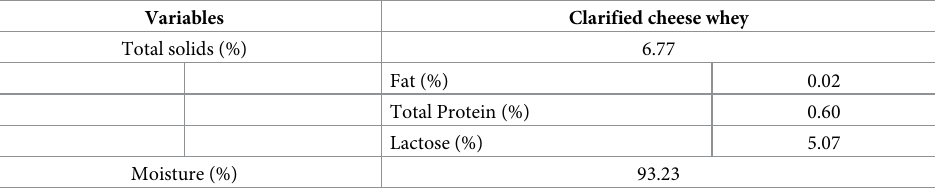
Table 1. Composition of clarified buffalo mozzarella cheese whey used for the cultivation of S . platensis